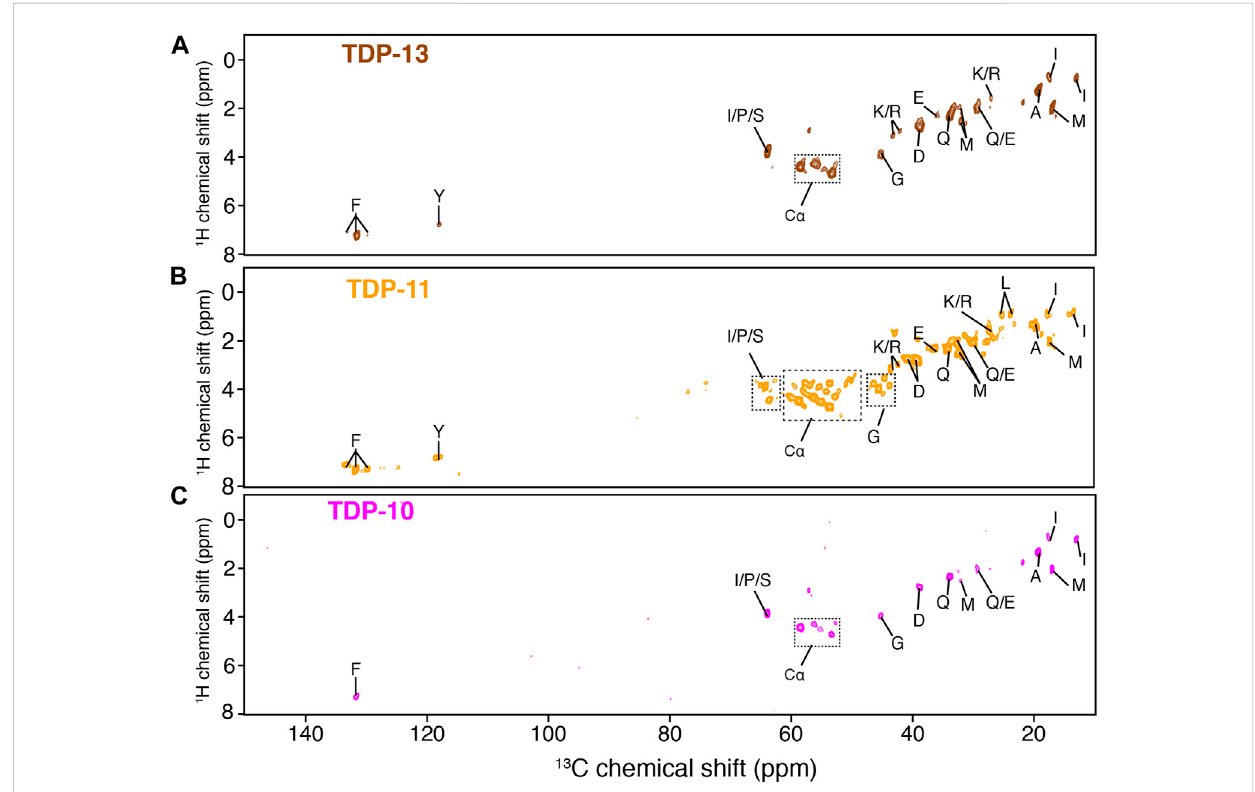
Detection of protein segments associated with high mobility by MAS NMR. 1 H- 13 C INEPT experiments of TDP-13 (in brown) (A) , TDP-11 (in orange) (B) , and TDP-10 (in pink) (C) amyloid aggregates. The data were recorded at a 1 H frequency of 600 MHz, 11 kHz MAS at 278